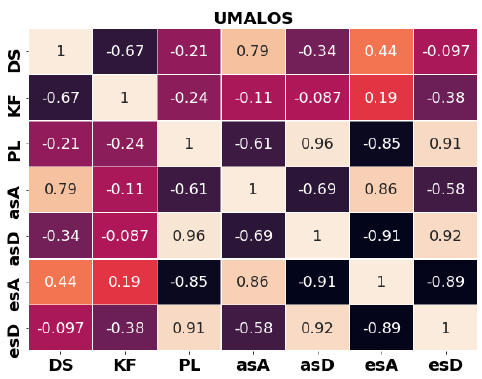
(c) Before normalization for RMa NLoS. (d) After normalization for RMa NLoS.